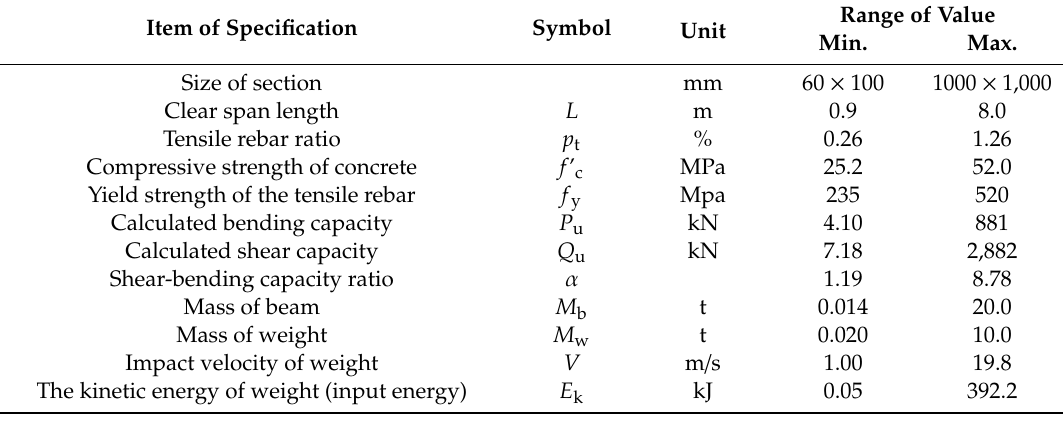
Table 2. Range of RC beam specifications (total of 134 cases).